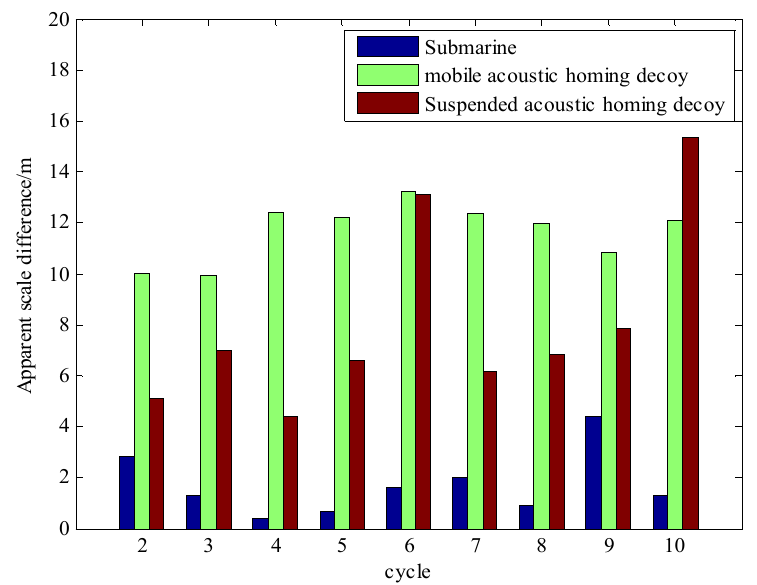
Figure 15. The apparent scale difference of each period.